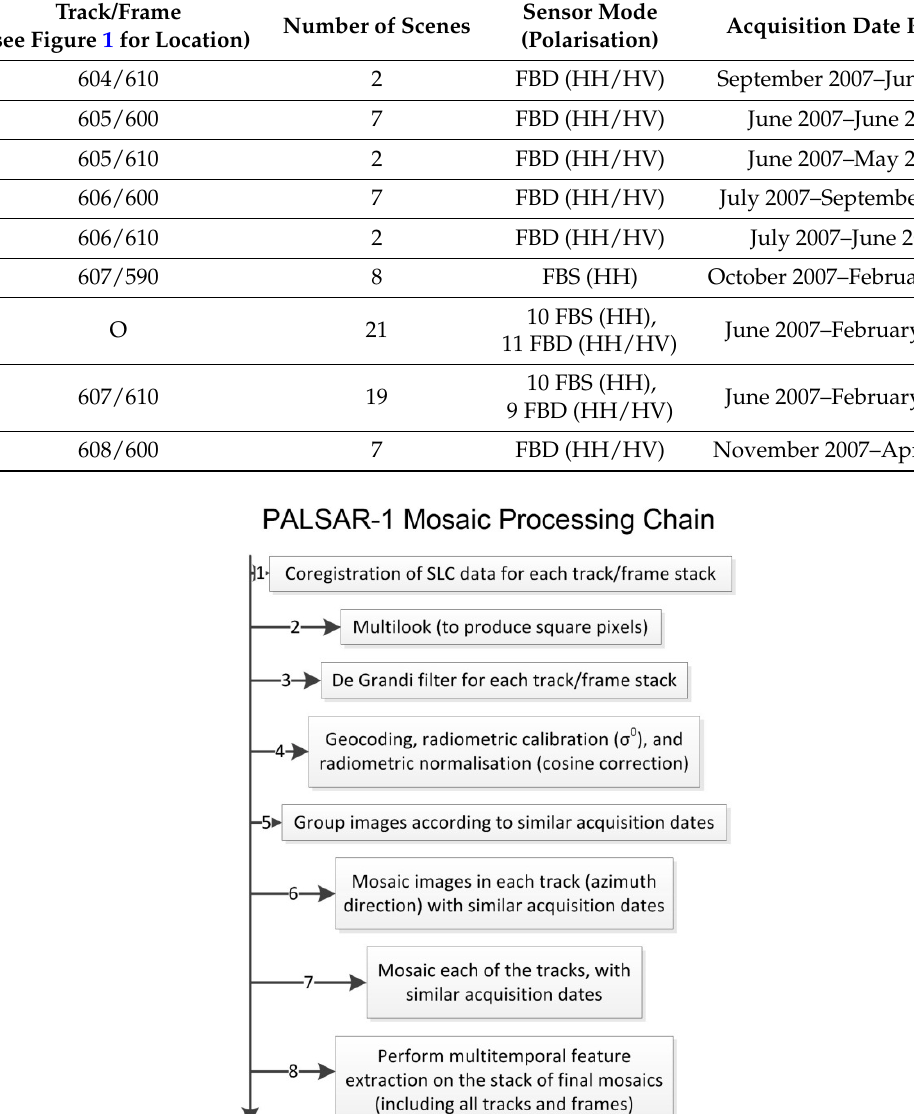
Table 1. ALOS PALSAR-1 data used in the mosaic. All scenes were acquired in ascending node, right looking, and with an incidence angle of 38.7 degrees. For the scene IDs of individual images, see Tables S1 and S2 in the Supplementary Materials. HV: Horizontal Transmit, Vertical Receive; HH: Horizontal Transmit, Horizontal Receive.